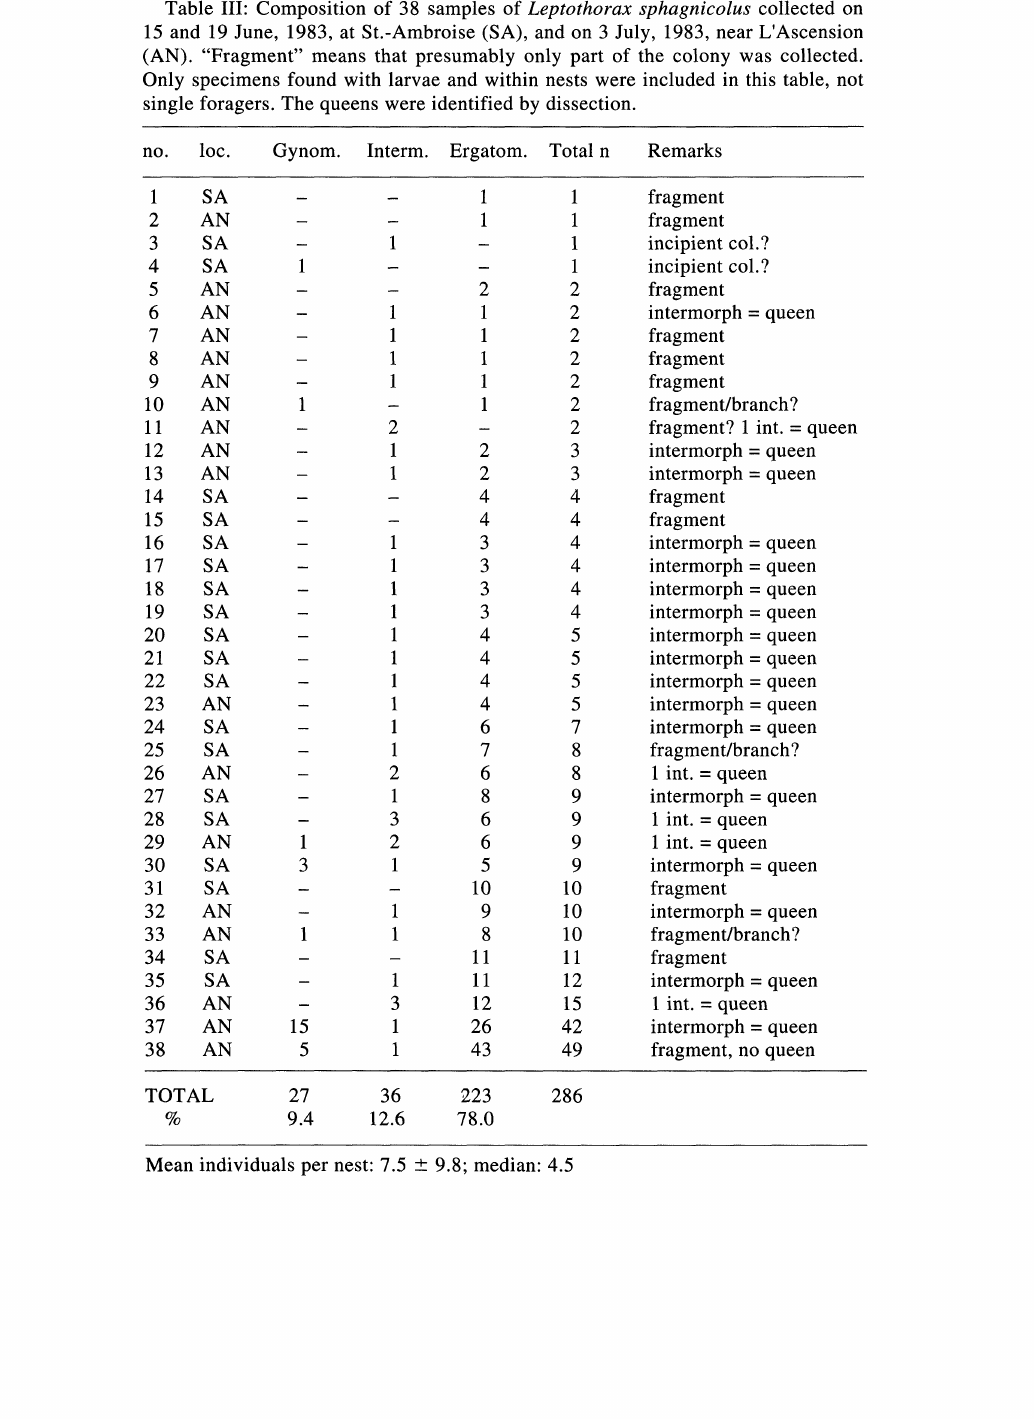
Table III: Composition of 38 samples of Leptothorax sphagnicolus collected on 15 and 19 June, 1983, at St.-Ambroise (SA), and on 3 July, 1983, near L’Ascension (AN). "Fragment" means that presumably only part of the colony was collected. Only specimens found with larvae and within nests were included in this table, not single foragers. The queens were identified by dissection. no. loc. Gynom. Interm. Ergatom. Total